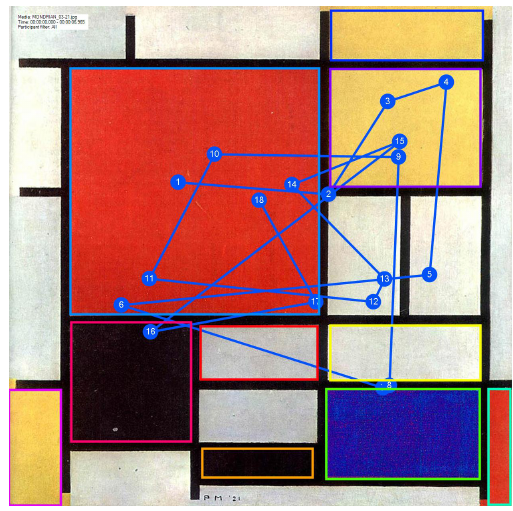
Figure 1: An example of a simple eye-tracking se- quence